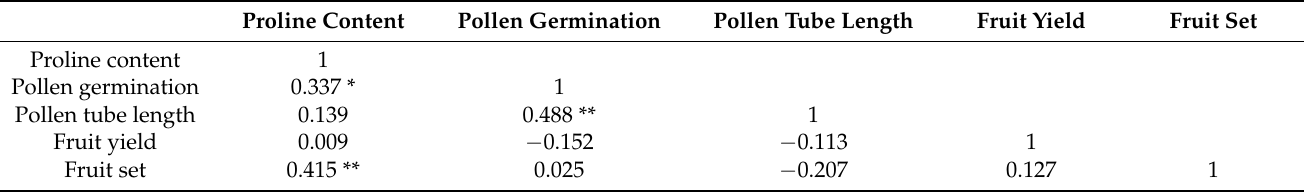
Table 1. Correlation between biochemical and reproductive traits at control temperatures (28 ◦ C).